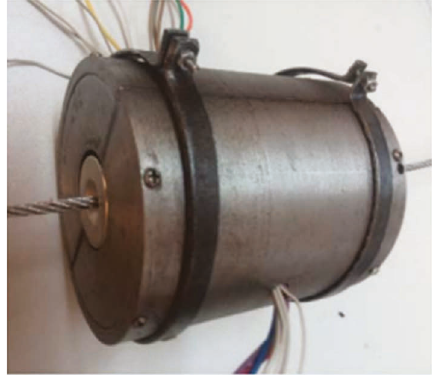
Figure 8: Wire rope damage detection